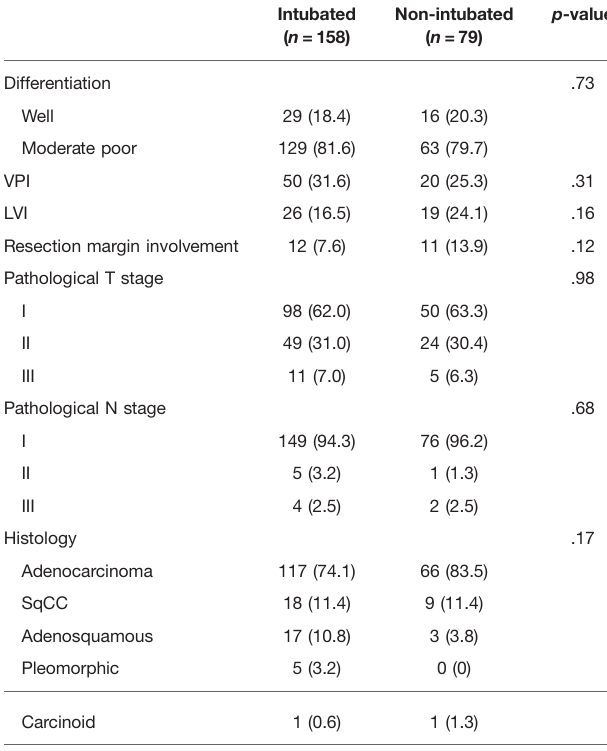
TABLE 3 | Pathological features after propensity score